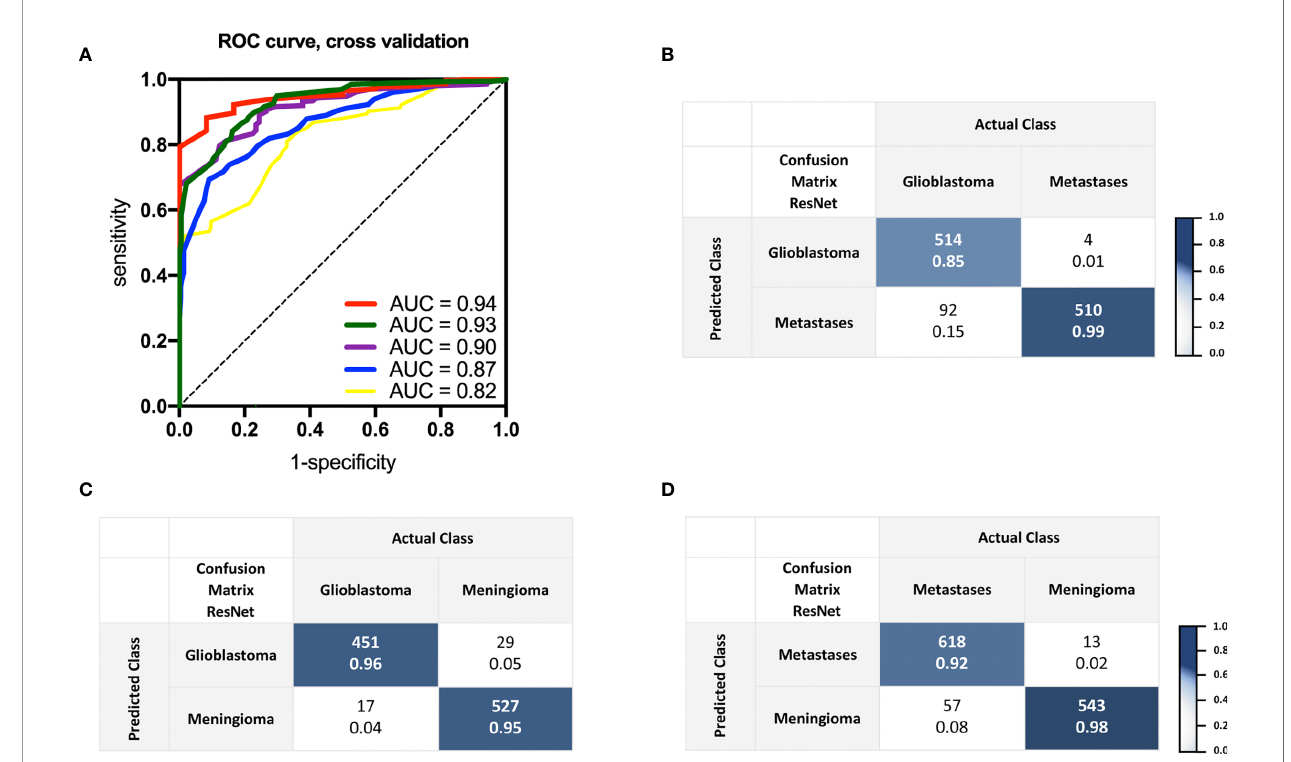
FIGURE 1 | (A) Receiver operating curve analysis and corresponding area under the curve values received of a trained two-class residual convolutional network with fi ve-fold cross validation. Images were obtained from seven patients with glioblastoma and brain metastases, respectively. (B) Confusion matrix shows outputs and actual labeling for binary classi fi cation of an additional test set, including one patient with glioblastoma and another one with brain metastases. (C, D) Confusion matrices indicating binary classi fi cation results of a test set for glioblastoma and meningioma as well as brain metastases and meningioma, respectively. In each cell, the number above is the count and the number below the normalized count. Images were obtained with CLE following topical ex vivo staining with fl uorescein dye.